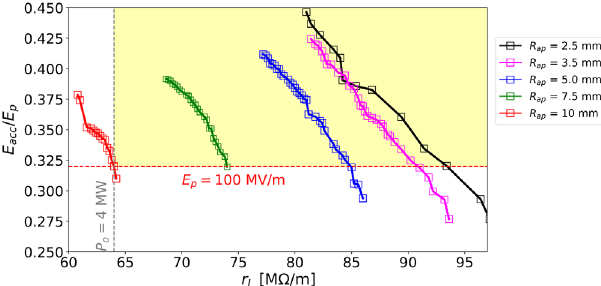
FIG. 13. Pareto front for a middle cell of a periodic structure as a function of aperture